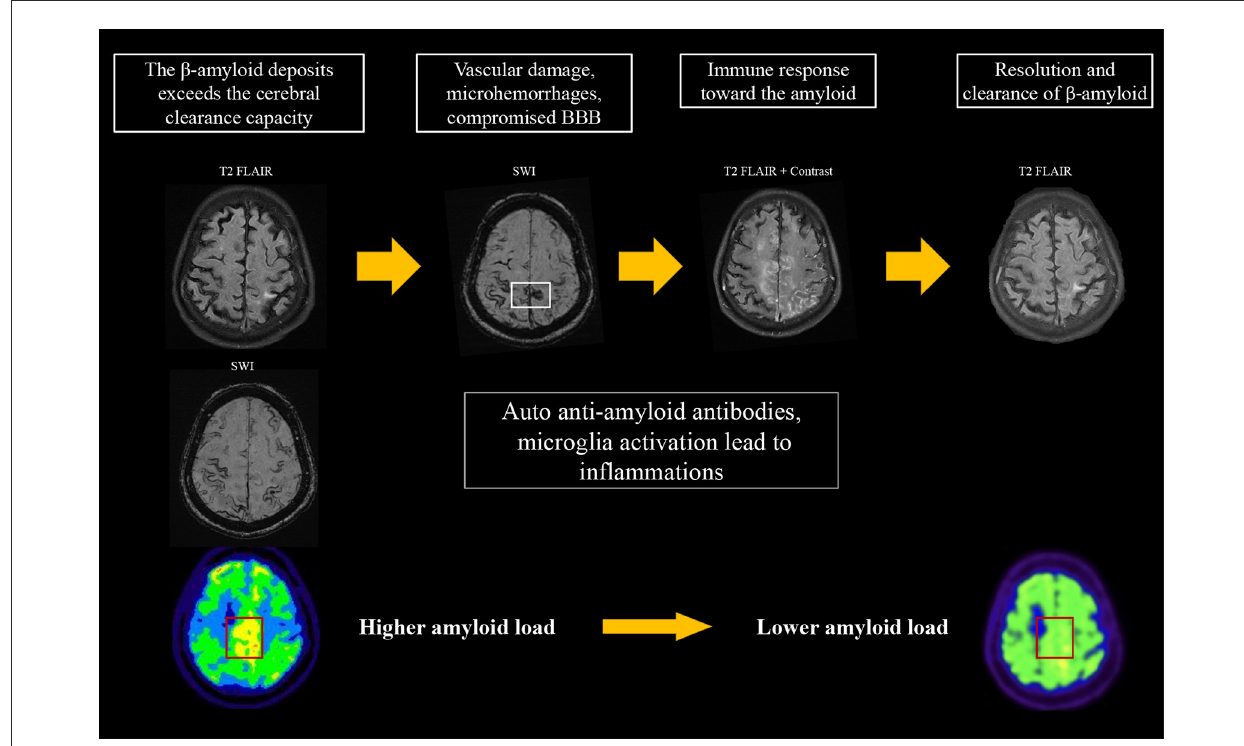
FIGURE3 Proposed hypothesis for the changes on amyloid PET in CAA-ri. An increase in amyloid burden exceeds the clearance capacity, which may lead to focal vascular damage and microhemorrhages. This process induces an immune response that involves auto-antibodies and activation of microglia/macrophages for the clearance of β - amyloid, resulting in the typical MRI features of CAA-ri. The focal amyloid load appears lower when inflammation